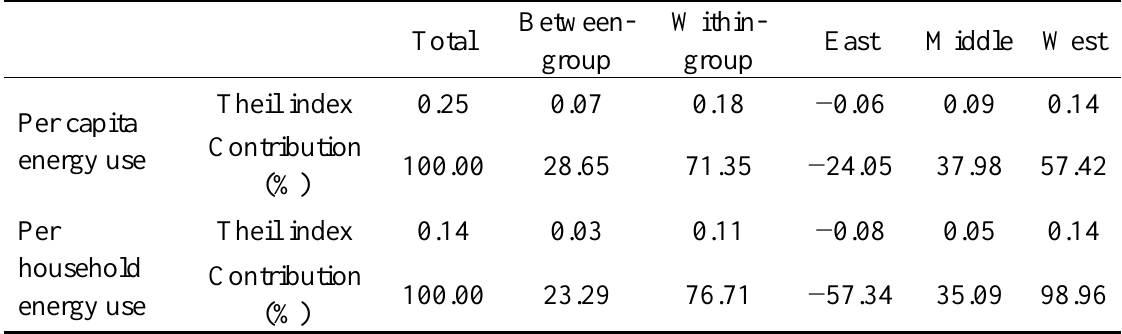
Table 1 . Theil index for energy consumption level across the 30 provincial capital cities of mainland China in